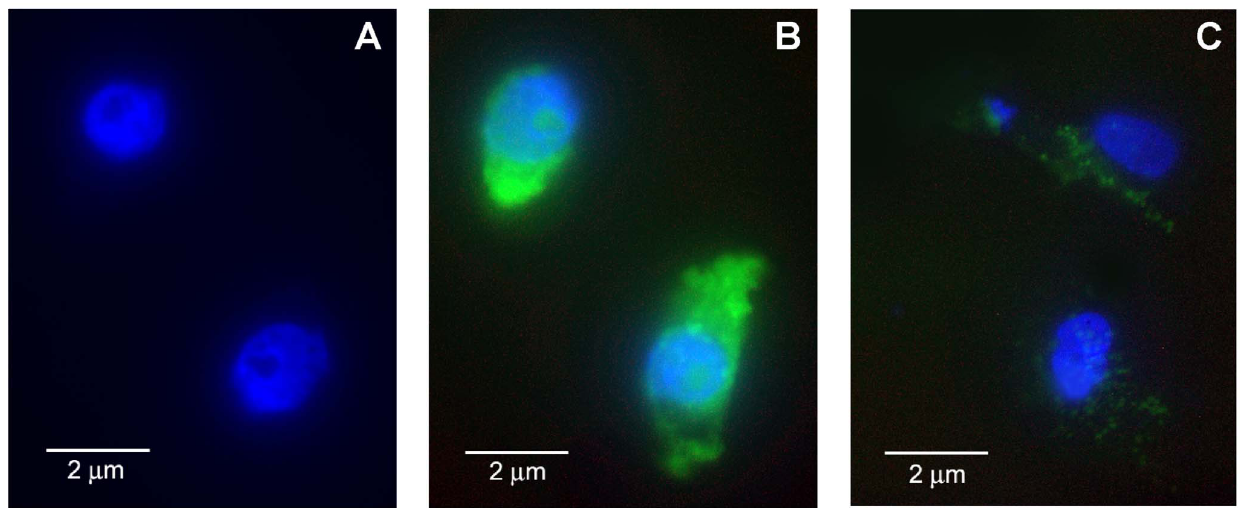
Figure 1. Endocytosis of FITC- k LC in cultured human proximal tubule epithelial cells (a representative field with two cells is shown). HK-2 cells were grown on a glass chamber in 8-well culture slide for 2 days and then observed by fluorescence microscopy. A. FITC without LC in control cells counterstained with DAPI for 30 min. B: after FITC-LC (25 m g/ml) uptake by HK-2 cells grown on slide chamber for 45 min at 37 u C after acid wash to strip membrane bound fluorescence and counterstained with DAPI shows distribution of FITC-LC in the cytosol (green fluorescence). C: Pretreatment with 1 uM receptor-associated protein (RAP) markedly inhibits FITC-LC fluorescence in HK-2 cells.